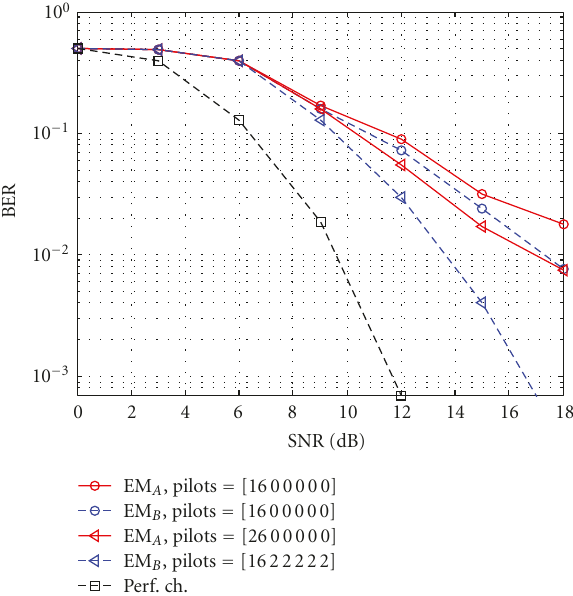
Figure 3: Comparison of EM - MMSE ( EM A ) and EM - FB -Kalman ( EM B ) algorithms.